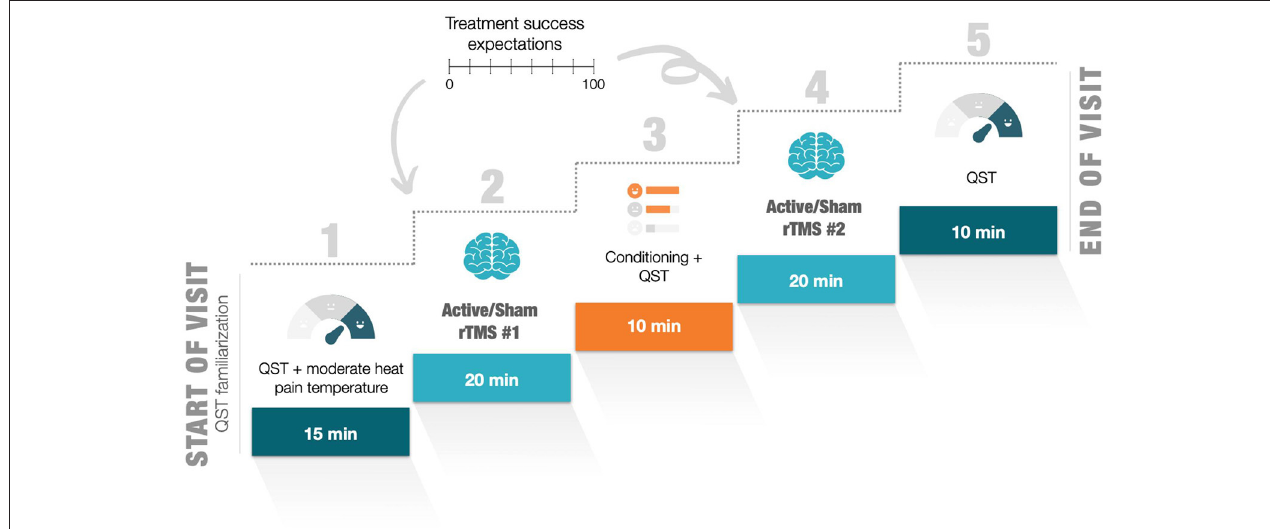
FIGURE 1 | Outline of the experimental procedure for each visit. QST, quantitative sensory testing; rTMS, repetitive transcranial magnetic stimulation; VAS, visual analog